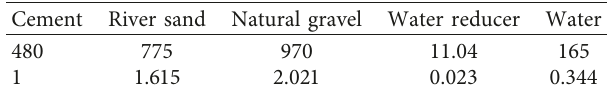
Table 2: Mix ratio of C40 ordinary concrete (kg/m 3 ).